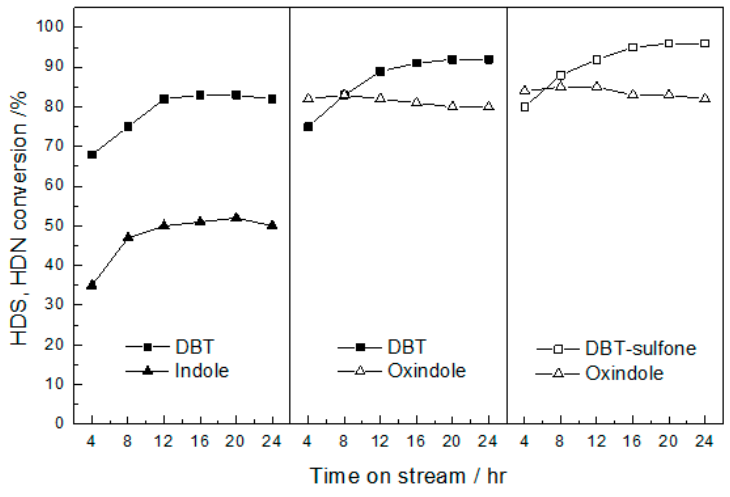
Figure 5. GC ‐ SCD chromatographs of LCO and reaction products. Figure 5. GC-SCD chromatographs of LCO and reaction products.